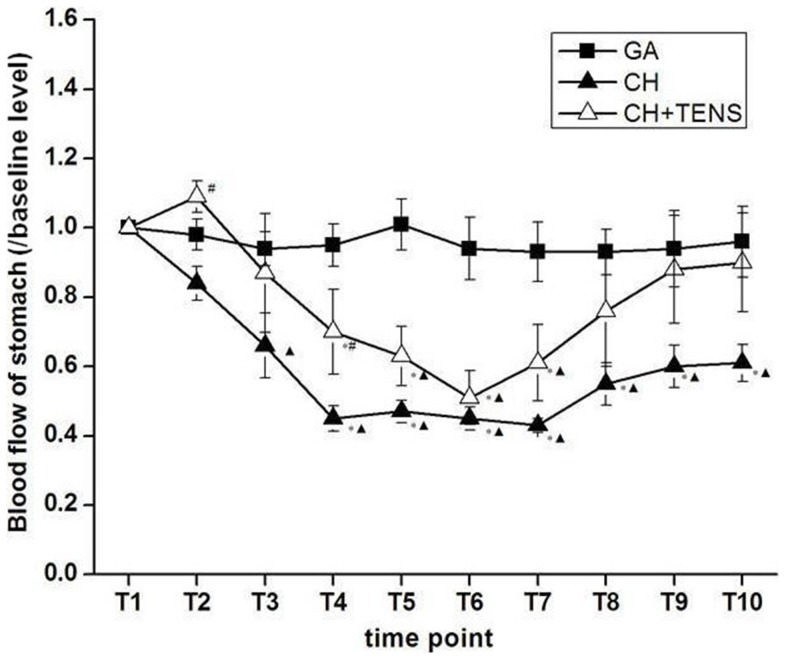
Blood flow to the stomach during controlled hypotension (CH).Gastric blood flow in the CH group was significantly less than baseline levels when mean arterial pressure (MAP) was lowered to reach target pressures and during the first 10 min of maintenance (T3–T4). TENS significantly prevented the decreased perfusion to the stomach. During the maintenance and MAP restoration stages (T5–T10), gastric blood flow in the CH group decreased significantly regardless of the cessation of SNP infusion. TENS also effectively inhibited the hypo-perfusion to the stomach in this period. By the end of T10, TENS was able to accelerate the recovery of low blood flow to the stomach caused by long-term hypotension. Data are presented as mean ± standard error of the mean. *P<0.05 vs. GA group, ▴
P<0.05 vs. basal level, #P<0.05 vs. CH group, n = 6 per group.